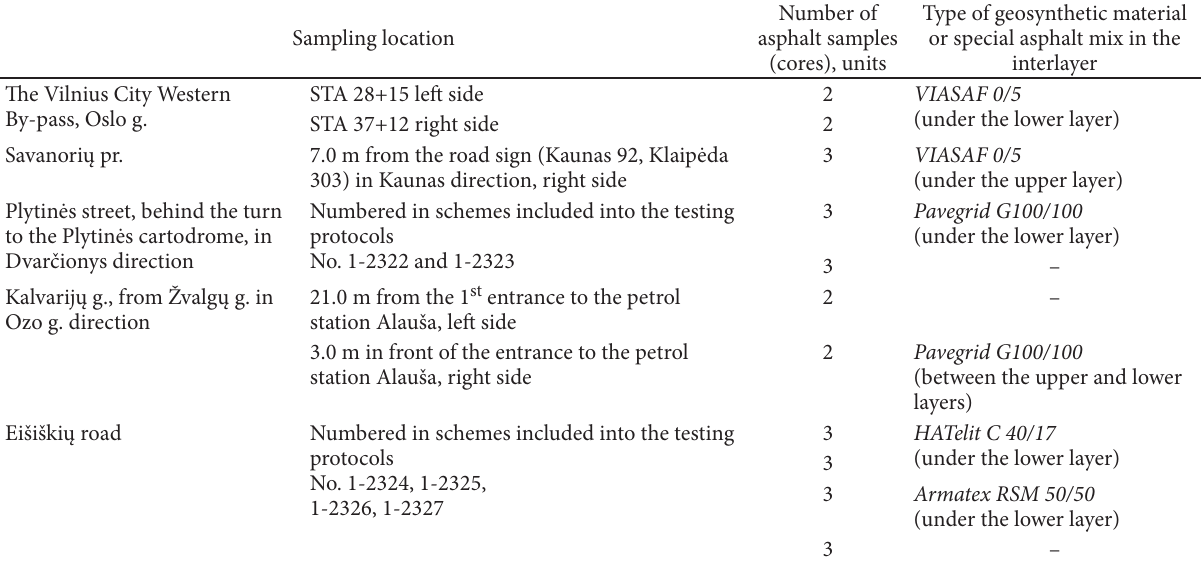
Table 2. Sampling locations in the Vilnius City